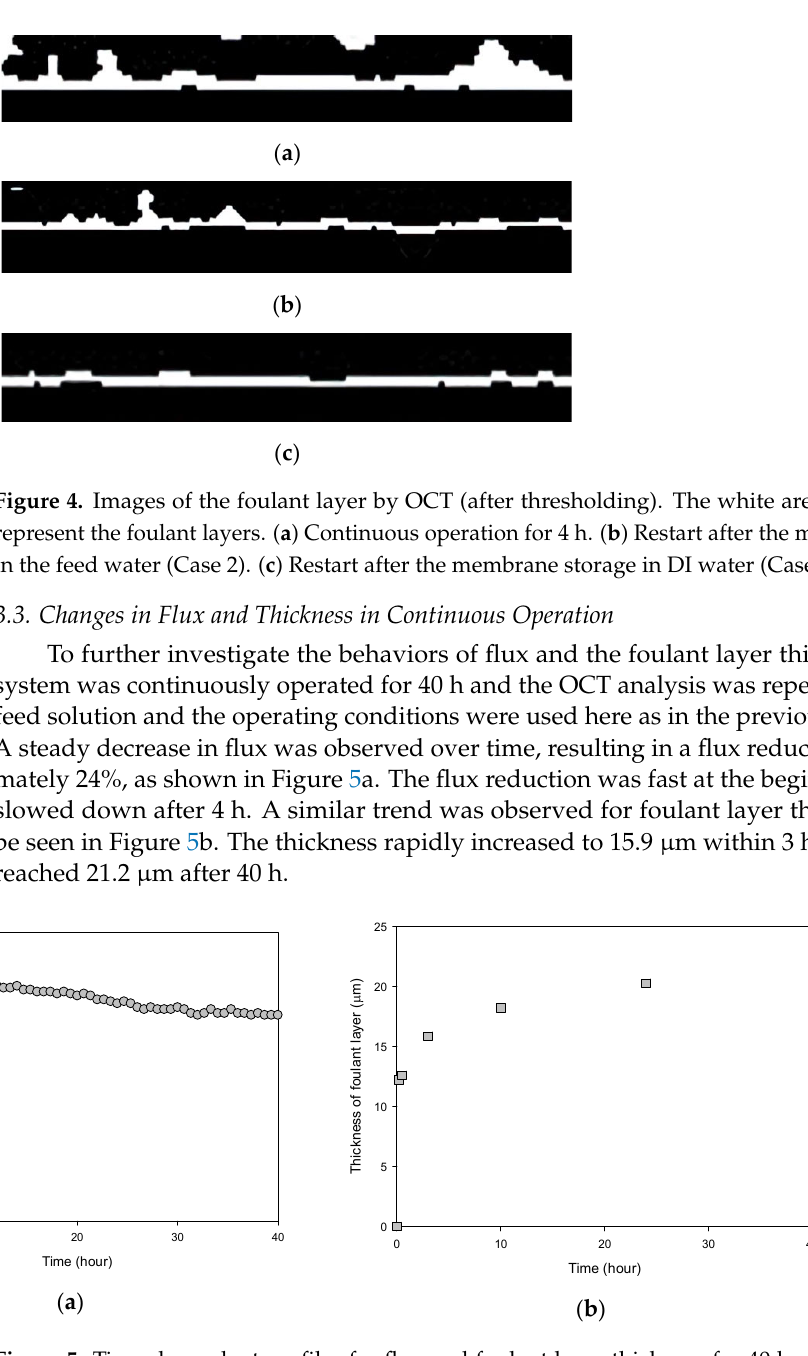
Figure 5. Time-dependent profiles for flux and foulant layer thickness for 40 h of continuous RO Figure 5. Time ‐ dependent pro fi les for fl ux and foulant layer thickness for 40 h of continuous RO operation: ( a ) flux and ( b ) foulant layer operation: ( a ) fl ux and ( b ) foulant layer thickness .